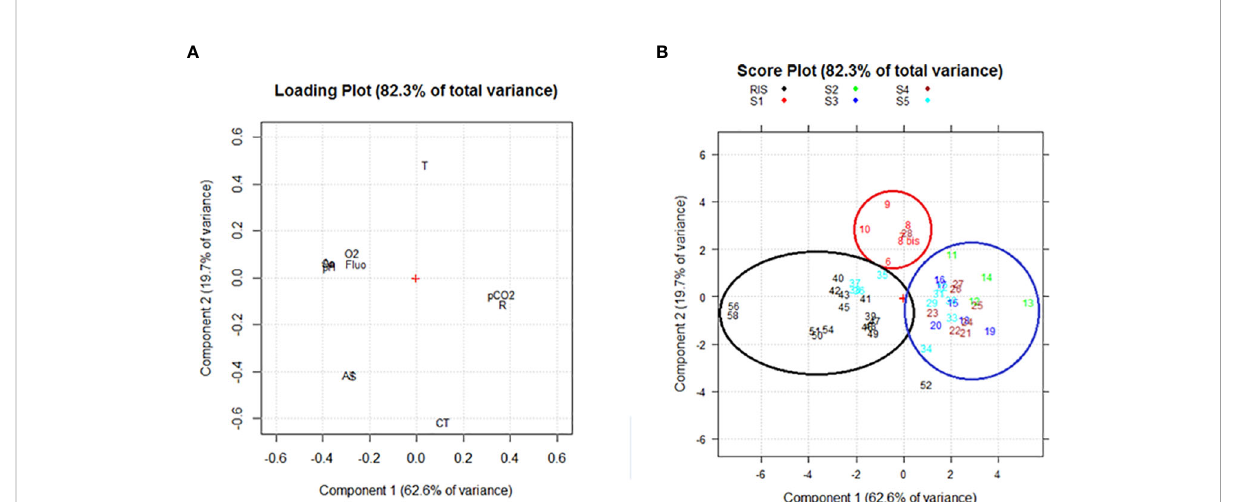
FIGURE 3 (A) Loading plot and (B) Score plot obtained from the PCA for the surface samples. The following abridgements were used for the variables in the loading plot: dissolved oxygen (O 2 ), total inorganic carbon (C T ), total alkalinity (A T ), partial pressure of CO 2 (pCO 2 ), Revelle factor (R), saturation grade of calcite and aragonite (Ca and Ar), fl uorescence (Fluo), temperature (T), and salinity